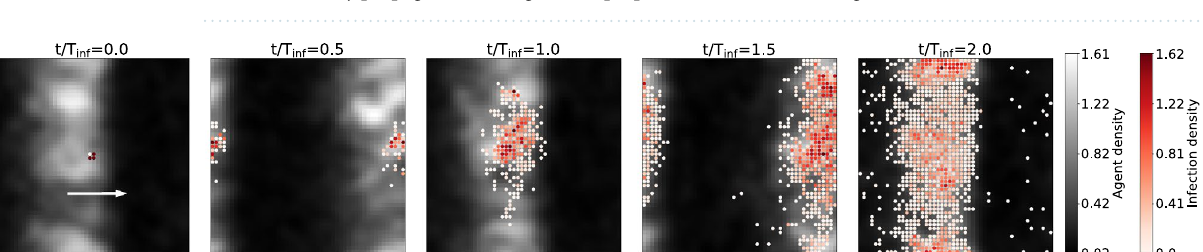
Figure 5. Infection dynamics in an ordered homogeneous state, visualized as in Fig. 4. The spatial dynamics corresponds to the ordered homogeneous state OH-1 presented in Fig. 1, with (Pe,g) = (512,16), here advancing to the right as indicated by the white arrow. The panels display the temporal evolution of a single infection 3 process (with T inf = 10 and (cid:31) = 2 ) started by 10 agents at the center of the arena. We observe that the infection initially propagates forming a band perpendicular to the heading direction.